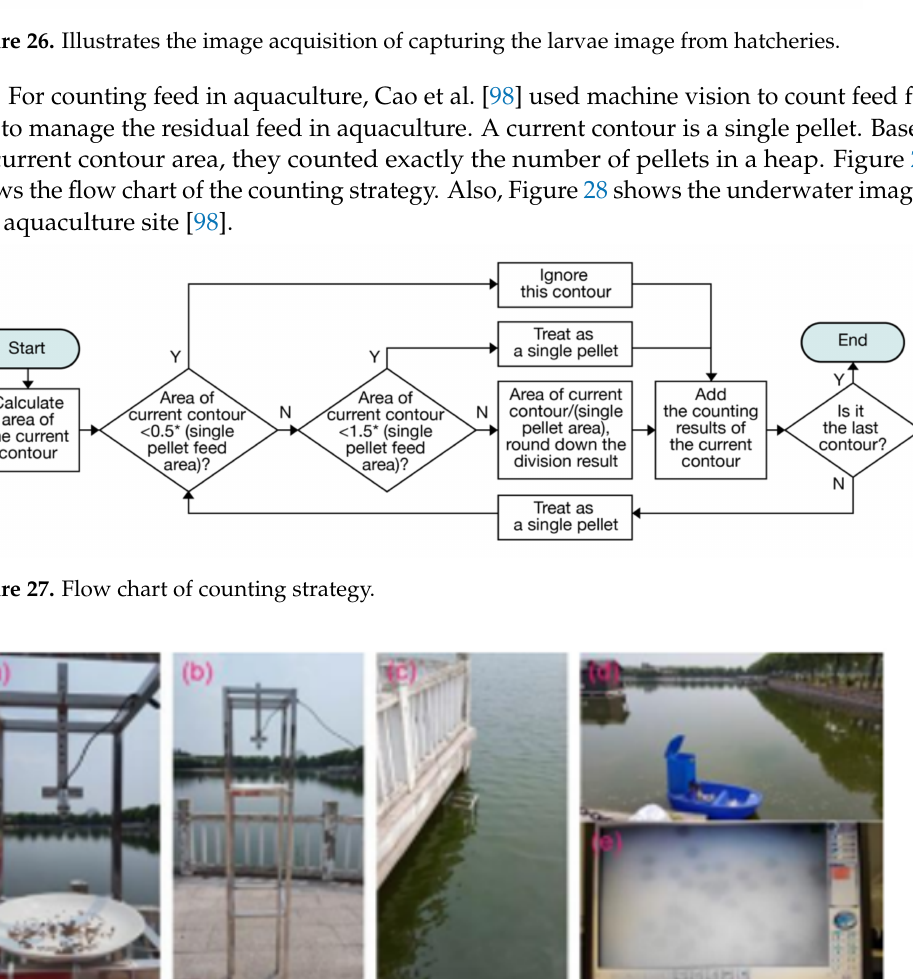
Figure 28. ( a – e ) The underwater imaging platform and the aquaculture